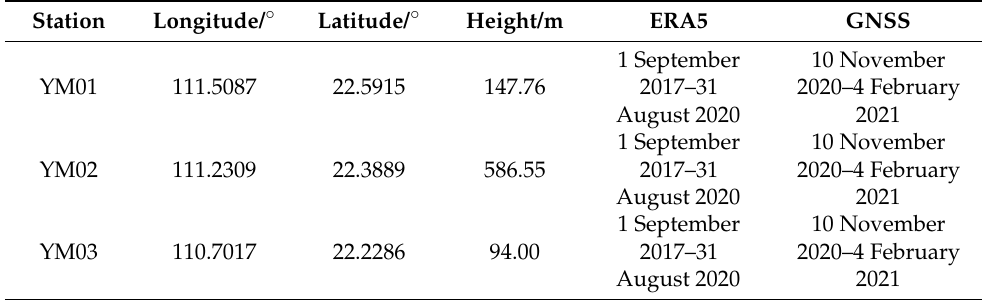
Table 1. Geographical information of the three ground-based GNSS collocated meteorological stations and statistics during the experimental data